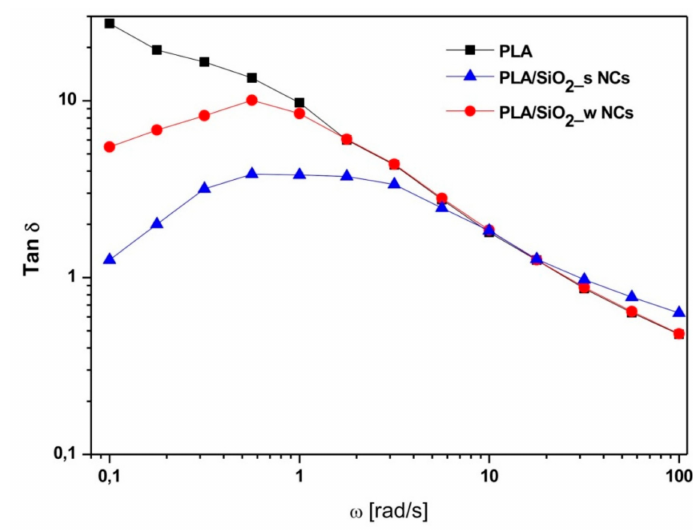
Figure 12. Loss factor tan δ of pure PLA and PLA / SiO 2_ s and PLA / SiO 2_ w nanocomposites.